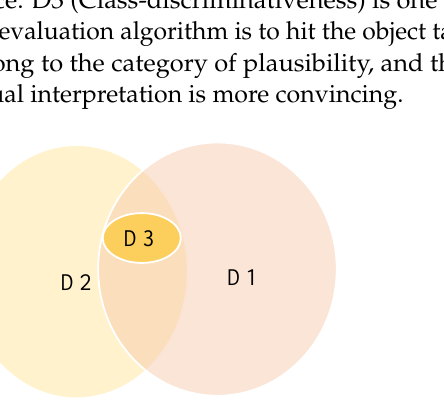
Figure 21. The Venn diagram of D1 (accuracy), D2 (persuasibility) and D3